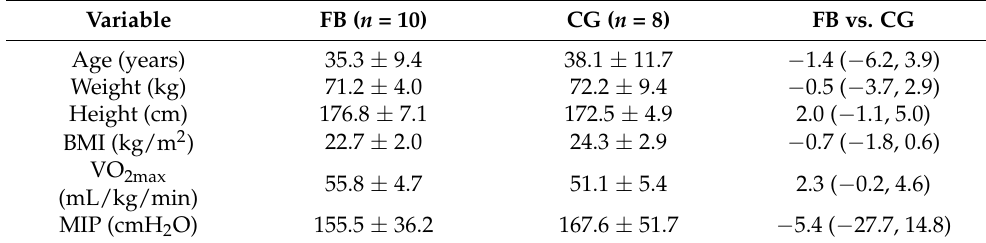
Table 1. Participant’s baseline characteristics by